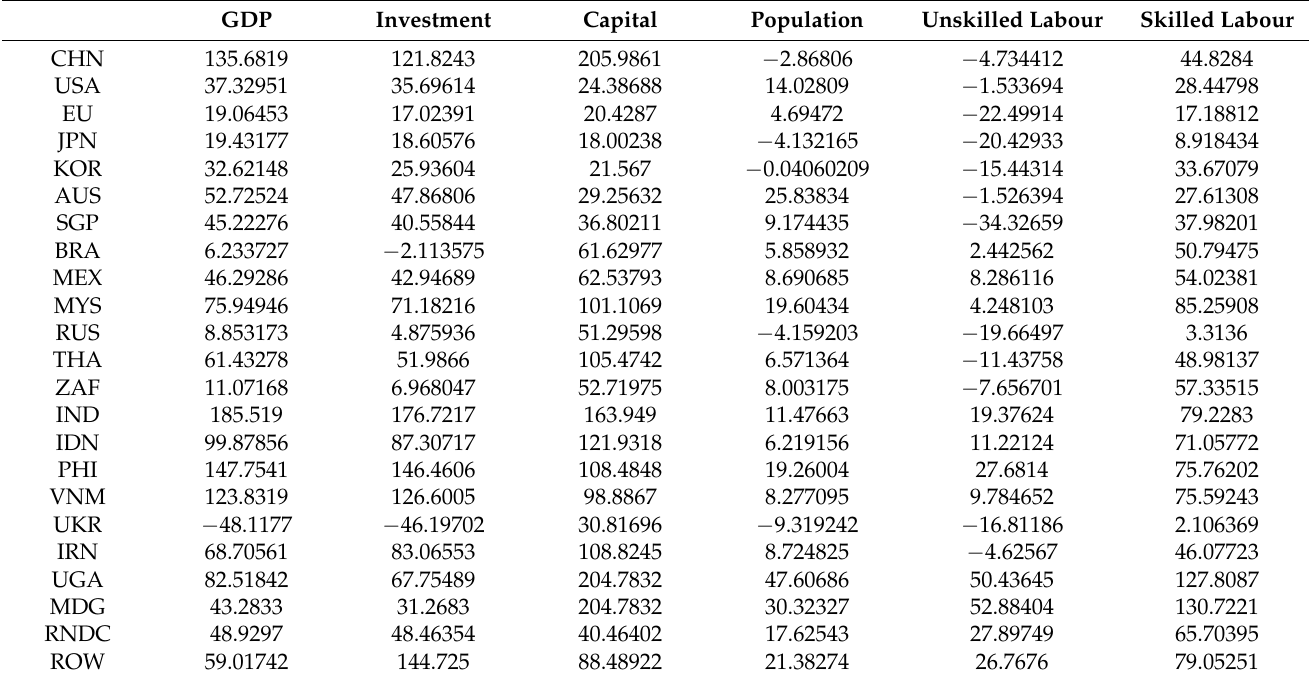
Table 2. Projection of macroeconomic growth from 2014 to 2030 (percentage